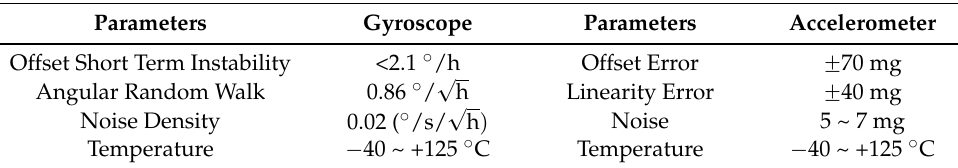
Table 1. Technical specifications for SCC1300-D04.